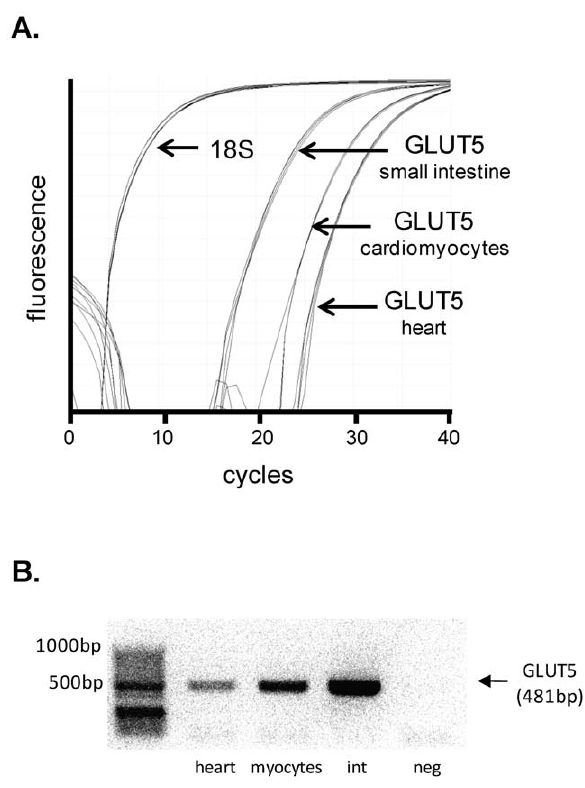
Figure 7. GLUT5 gene expression in cardiomyocytes. A. Real time PCR fluorescence depicting GLUT5 (Slc2a5) gene expression relative to 18S in adult rat isolated cardiomyocytes, heart and small intestine (positive control). B. DNA gel image from conventional RT-PCR of GLUT5 (Slc2a5) in rat heart tissue and isolated cardiomyocytes. GLUT5 primers were designed to obtain a 481 bp PCR product. Small intestine (‘int’) tissue was used as a positive control. Negative control (‘neg’) was obtained by RNA that was not reverse-transcribed to